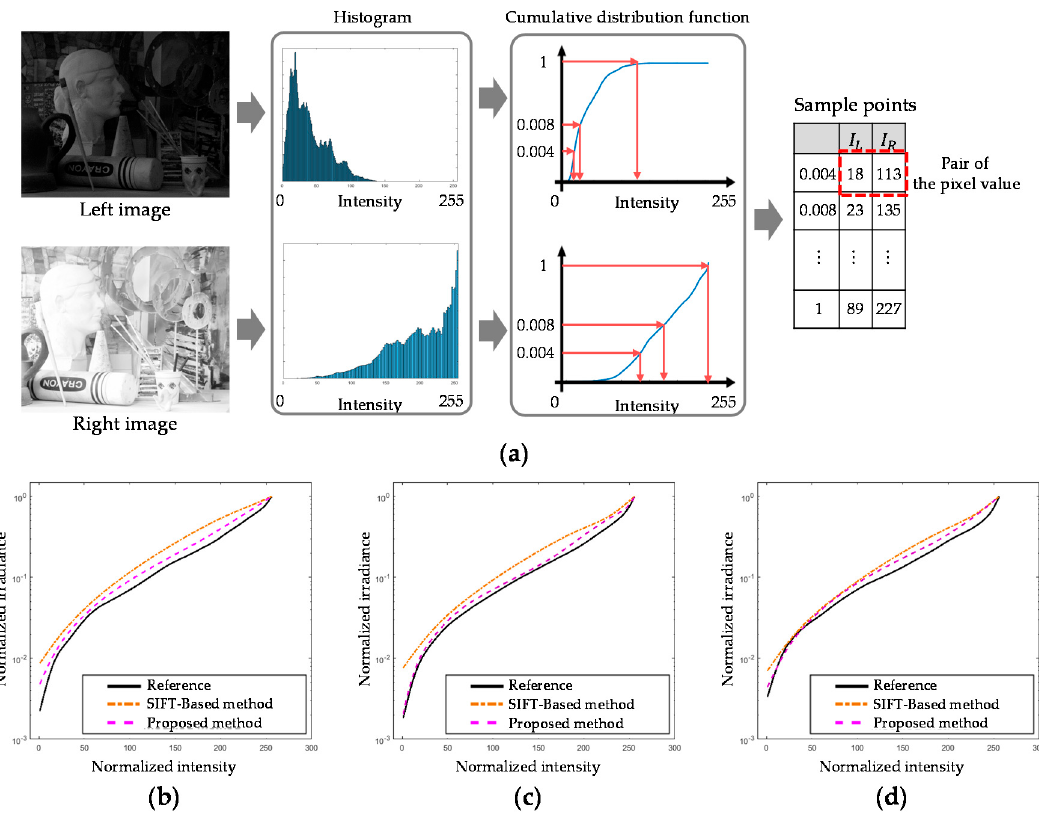
Figure 1. A framework of the proposed stereo high dynamic range (HDR) imaging.